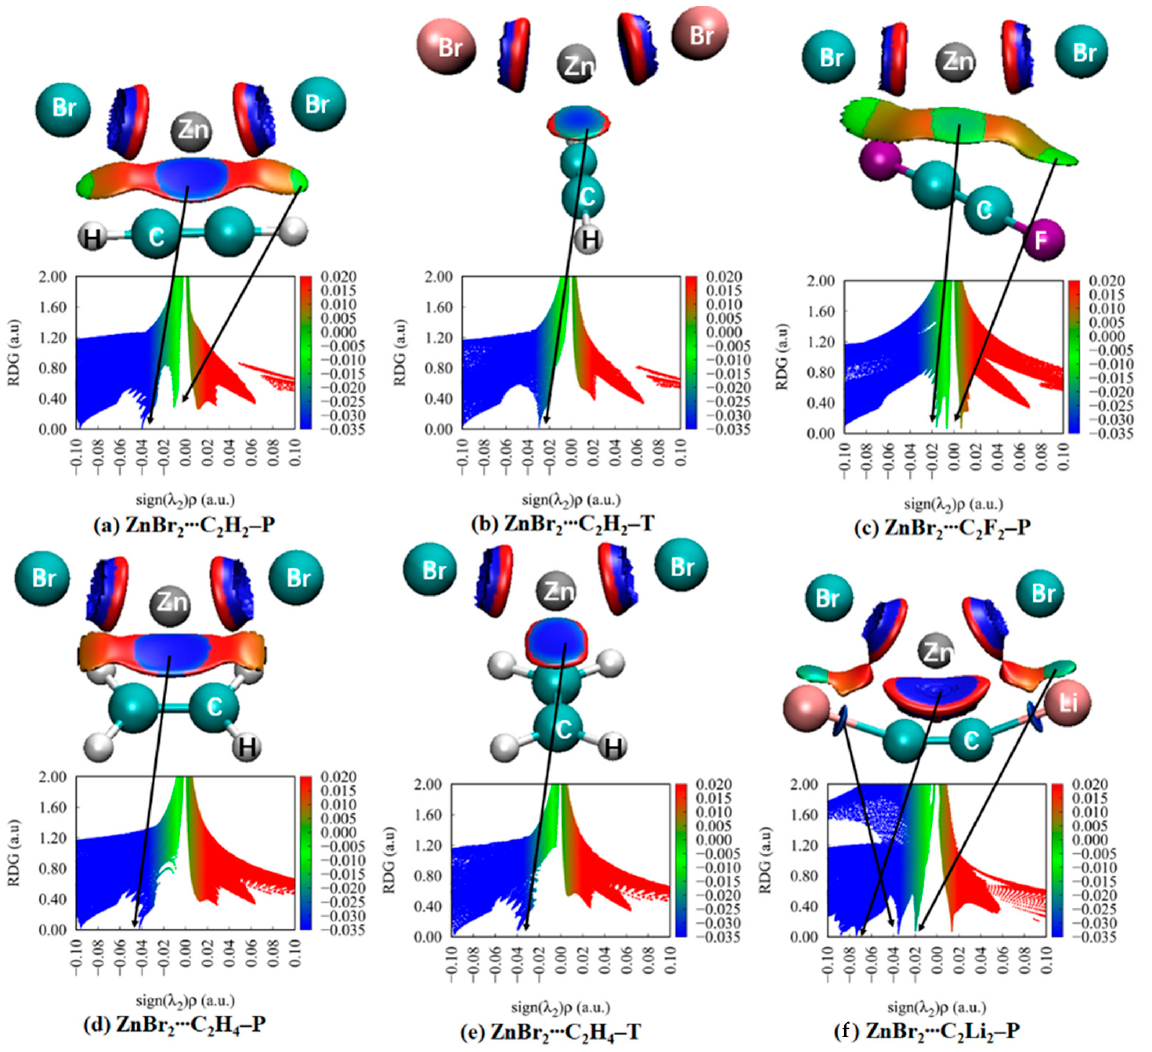
f Figure 4. Plots of the reduced density gradient RDG versus the electron density multiplied by the sign of the second Hessian eigenvalue (sign( λ 2 ) ρ ) of the selected binary complexes. NCI maps of the corresponding binary complexes. Blue, green, orange, and red areas correspond to strong attractive, weak attractive, weak repulsive, and strong repulsive interactions, respectively. In MX 2 ··· C 2 H 2 –P (Figure S2), there are two spikes in the negative value of the abscissa. The more negative one (about − 0.04 a.u. for Zn in Figure S2a–c, − 0.03 a.u. for Cd in Figure S2d–f, − 0.02 a.u. for Hg in Figure S2g–i) represents the spodium– π interaction, characterized by a large blue or green disc. The less negative spike ( − 0.01 a.u.) is referred to the two regions of weak X ··· H interaction between the H of C 2 H 2 and X of MX 2 , shown by flakes. Evidently, the weak X ··· H interaction cannot be detected in the AIM but can with the NCI method. The former interaction is evidently stronger than that of the latter. Between the two interactions mentioned above, a red or orange region indicates a repulsive interaction, which accounts for the coulomb repulsive interaction. In MX 2 ··· C 2 H 2 –T (Figure S3), there is only one spike in the negative value of the abscissa representing spodium– π interaction. Moreover, the spike in MX 2 ··· C 2 H 2 –T is less negative than that in the P form. It indicates that the spodium– π interaction in the P form is stronger than that in the T form. For MX 2 ··· C 2 H 4 –P (Figure S4), the spodium– π spike ( − 0.02 a.u. to − 0.04 a.u.) and repulsive spike are analogous to MX 2 ··· C 2 H 2 –P. The spike of X ··· H interactions disappears in ZnX 2 ··· C 2 H 4 –P (Figure S4a–c) and CdX 2 ··· C 2 H 4 –P (Figure S4d–e) and appears in HgX 2 ··· C 2 H 4 –P